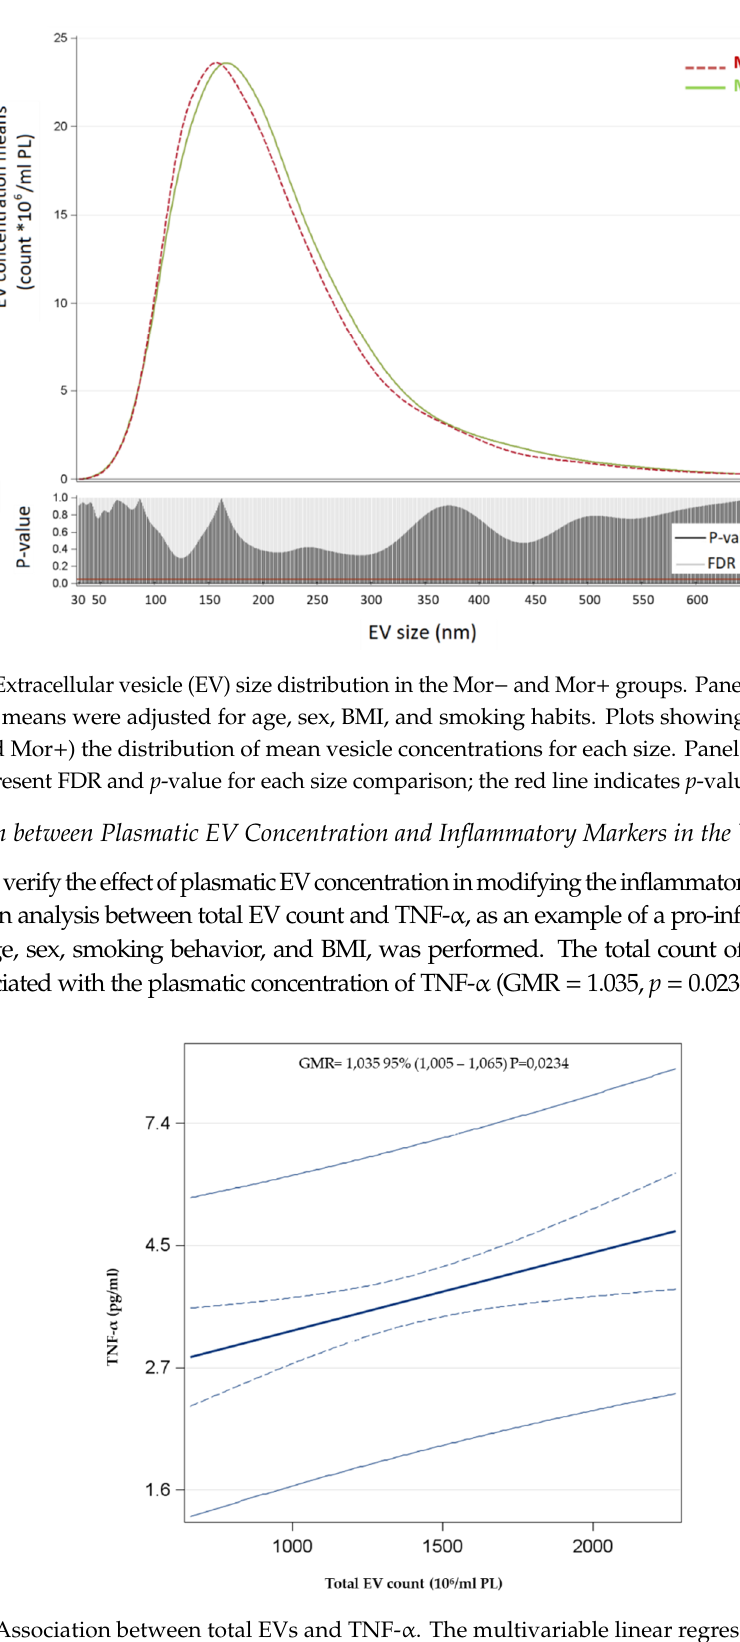
Figure 3. Association between total EVs and TNF- α . The multivariable linear regression model was adjusted for age, gender, smoking behavior (Never smoker, Former smoker, Current smoker), and